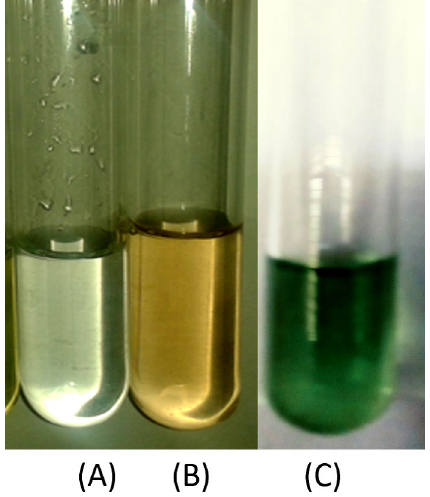
Fig. 4. Reaction of Purified laccase with substrates A) FPLC purified lacase B) Fractio with guiacol C) Fraction with ABTS